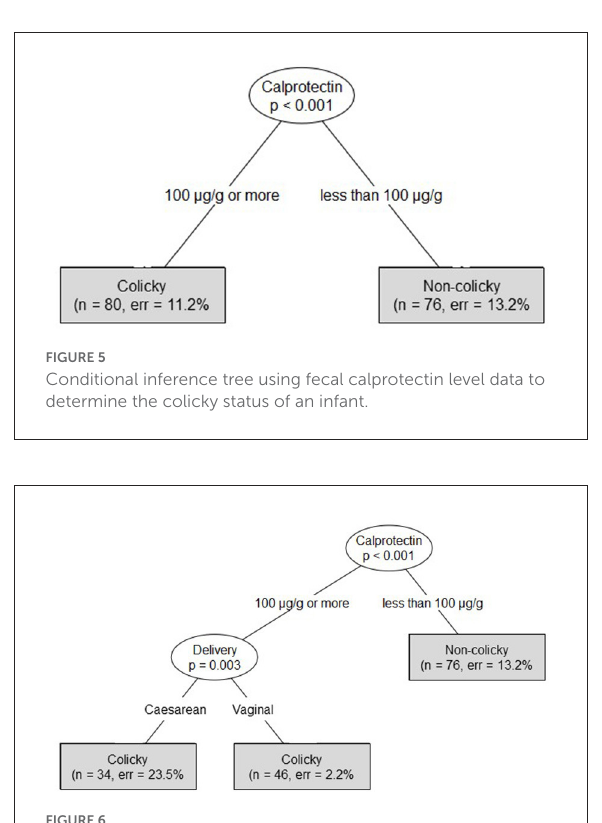
FIGURE6 Conditional inference tree using fecal calprotectin level data and information about the type of delivery to determine the colicky status of an infant.